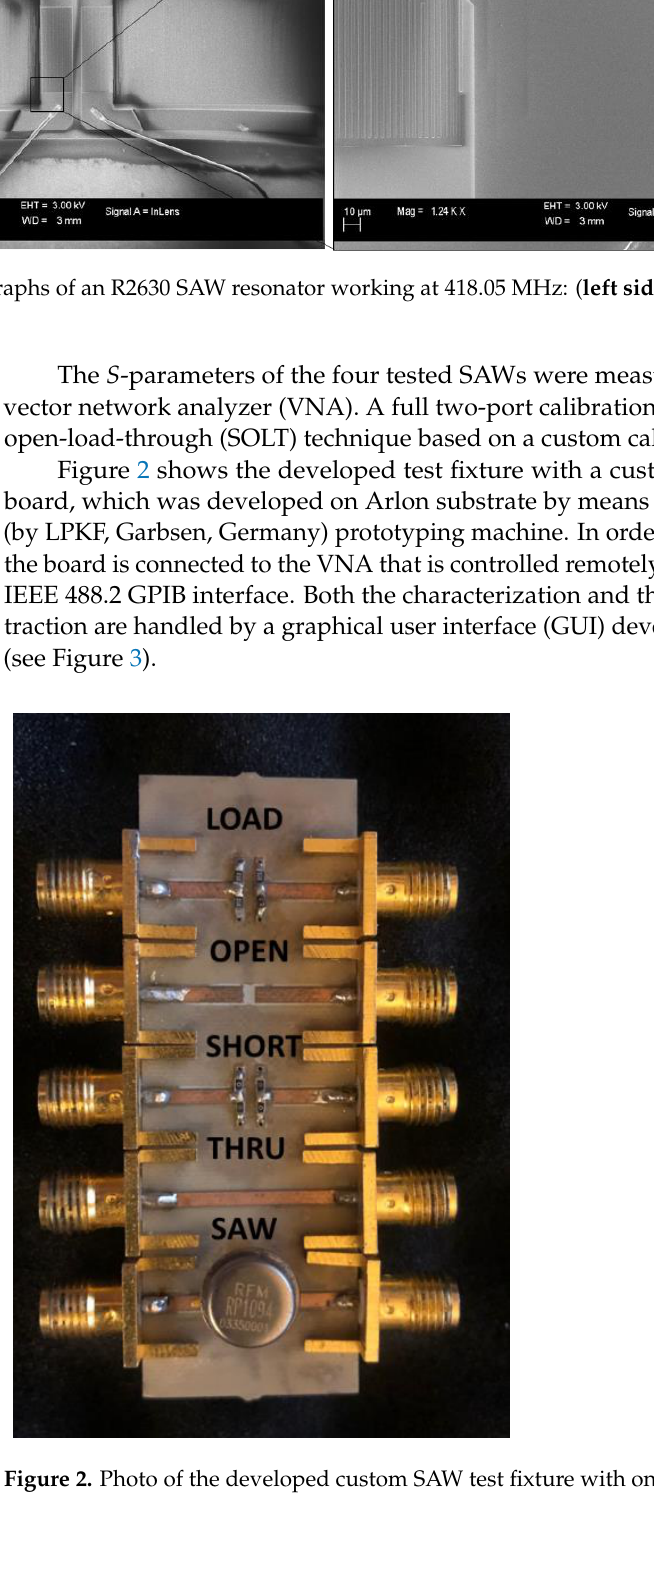
Figure 2. Photo of the developed custom SAW test fixture with on board SOLT calibration kit.